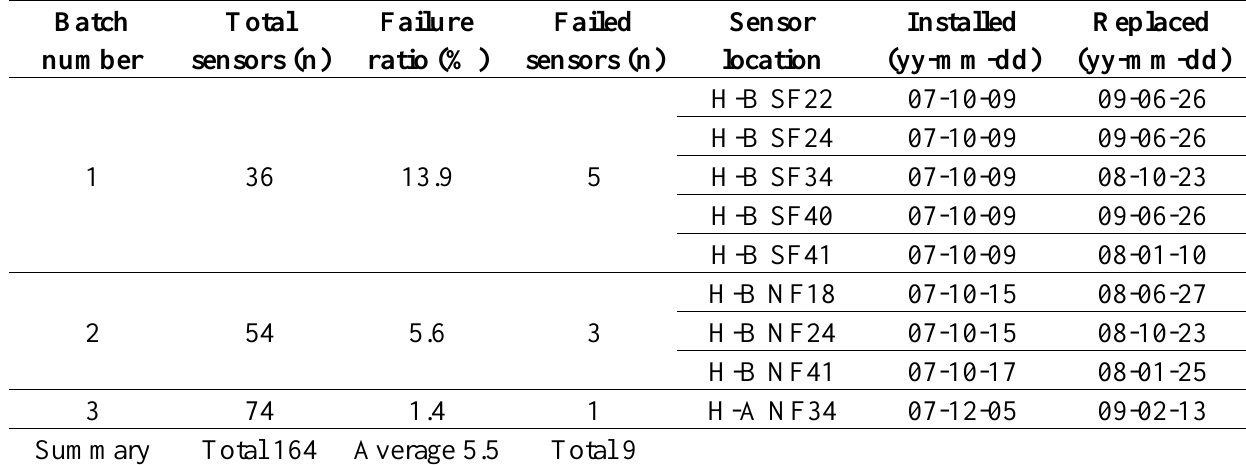
Table 3. Vibration sensor replacement in the two houses due to sensor